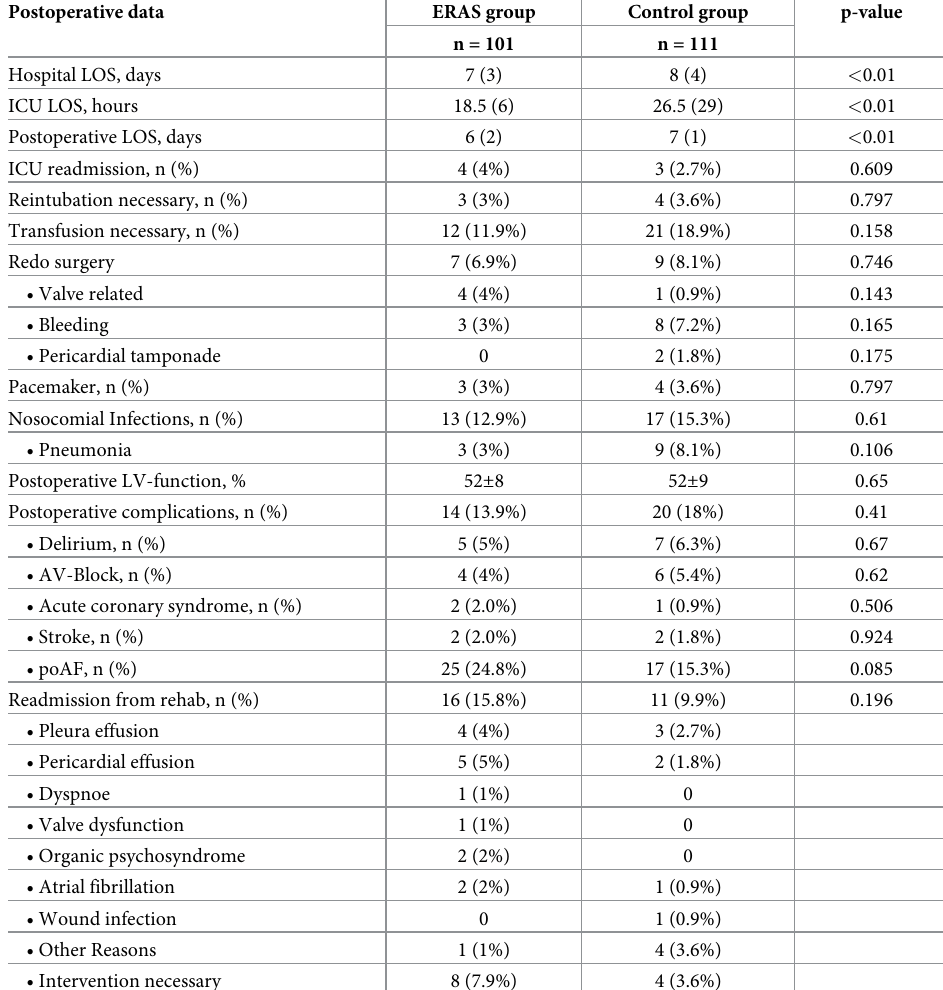
Table 3. Postoperative